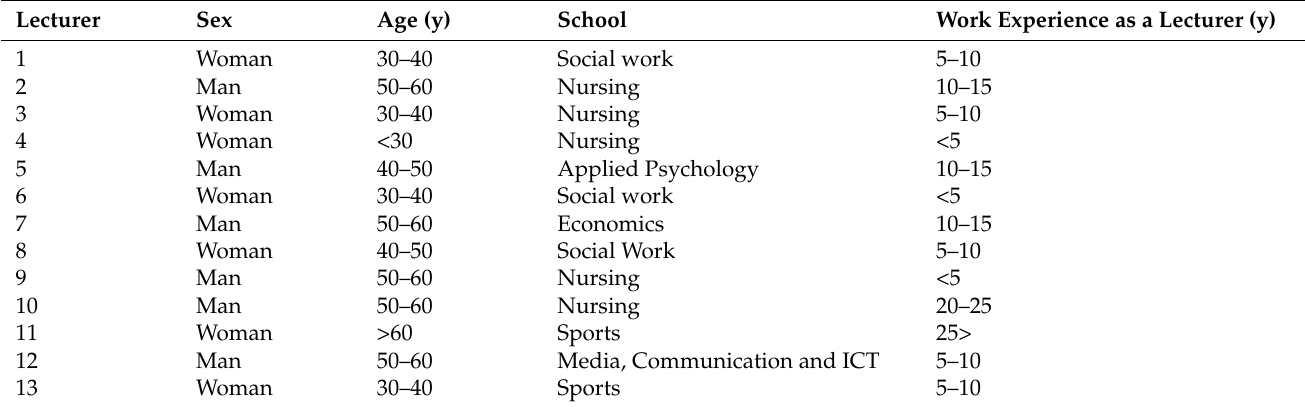
Table 2. Background characteristics of the interviewed